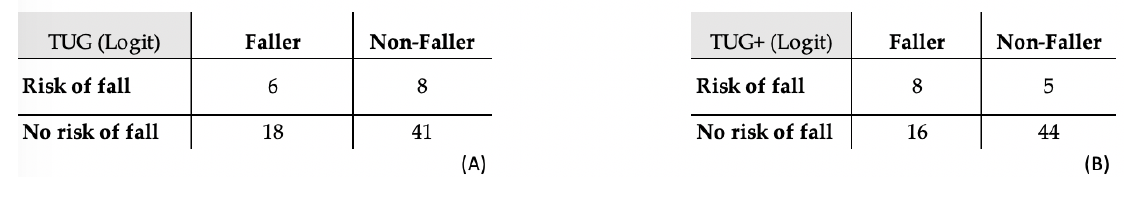
Figure A1. Confusion matrices for the logistic regression-based versions of the TUG and TUG+ tests. ( A ) TUG test. ( B ) TUG + test. Table A1. Characterization of the TUG (Logit) and TUG+ (Logit) tests. Values in bold font represent improvements of TUG+ (Logit) test with respect to TUG (Logit) test.